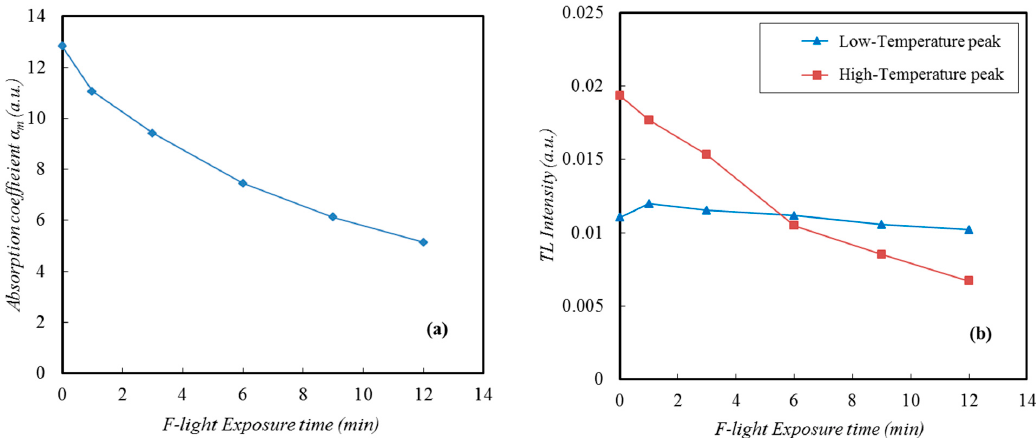
Figure 9. Variations of ( a ) absorption coe ffi cient and ( b ) each peak on TL glow curve of X-ray irradiated (irradiation time: 8 min) KCl:Eu 2 + (0.1 mol%) single crystals with F -light (excitation bandpass: 5 nm) exposure time.